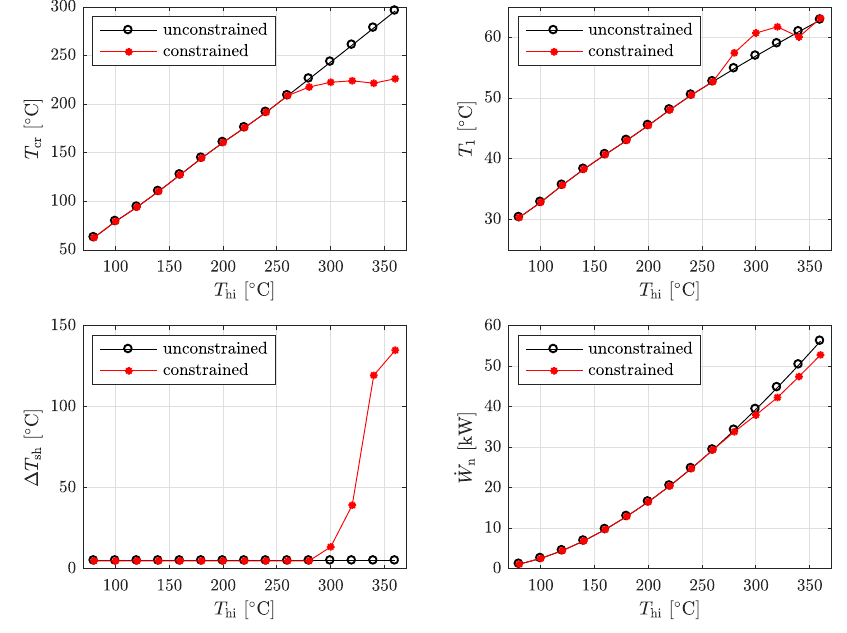
Figure 5. Optimal working fluid and cycle parameters for different heat-source temperatures for a subcritical cycle. Results obtained for an unconstrained ( p 1 ≥ 5 kPa) and constrained ( p 1 ≥ 100 kPa) condensation pressure with ω =